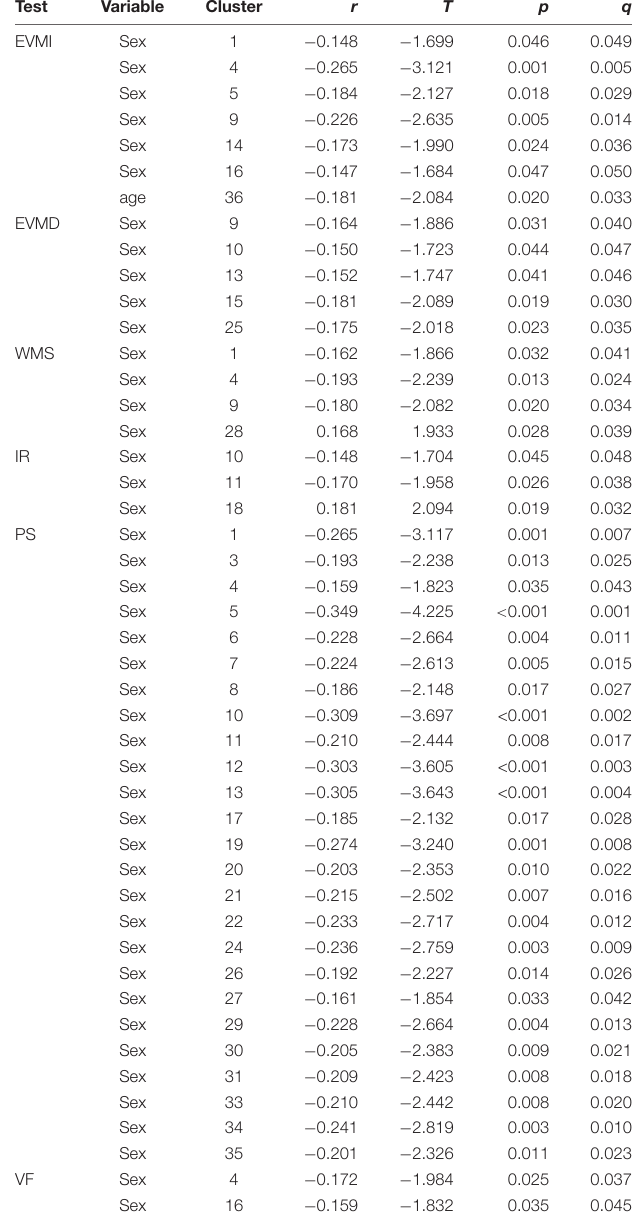
TABLE 2 | Statistically significant correlations between FC changes involving significant cortical clusters identified through GLM and cognitive task performance.